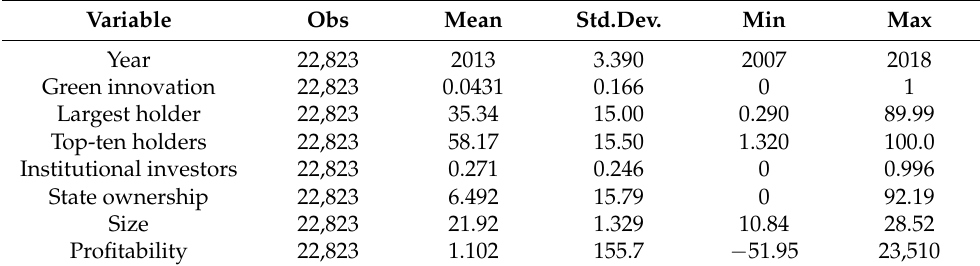
Table 2. Summary